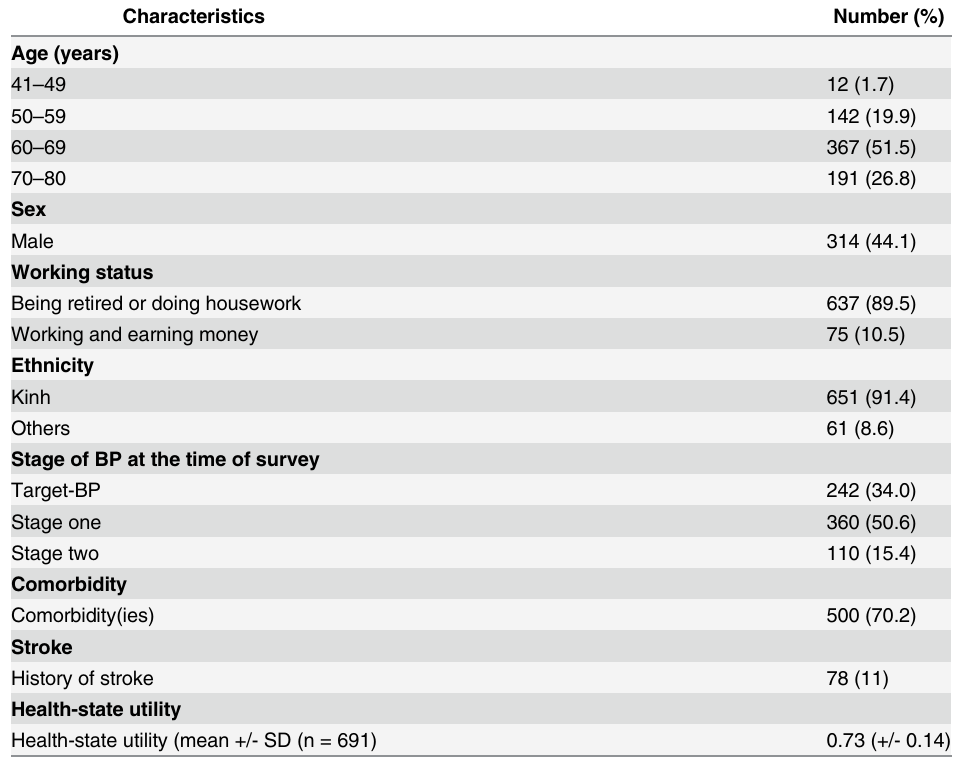
Table 1. Characteristics of patients included in the study (n =